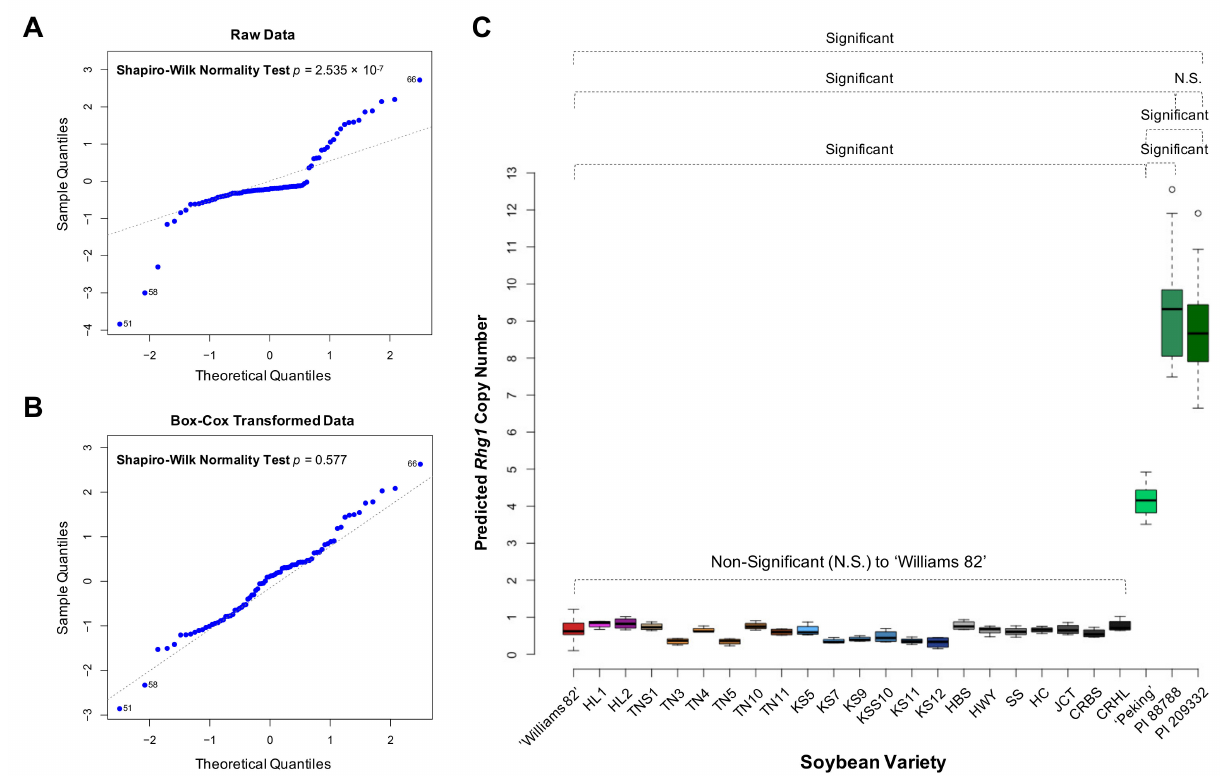
Figure 2. Prediction of the rhg1 copy number in soybean varieties. ( A ) The quantile–quantile plot (Q-Q plot) showed the raw data of the relative fluorescent unit (RFU) ratio (VIC/FAM) violated the assumptions of normality. ( B ) The Q-Q plot showed that Box–Cox transformation evidently improves the normality violation, and the transformed data were subjected to the Gaussian linear modeling. ( C ) The rhg1 copy number prediction using the Gaussian linear model with Box–Cox transformed data successfully separated three resistant varieties including ‘Peking’, PI 88788, and PI 209332 from the susceptible variety ‘Williams 82’. None of the soybean varieties developed in Taiwan showed significant difference to ‘Williams 82’. The significance of student’s t test was declared based on the Bonferroni-adjusted p value at